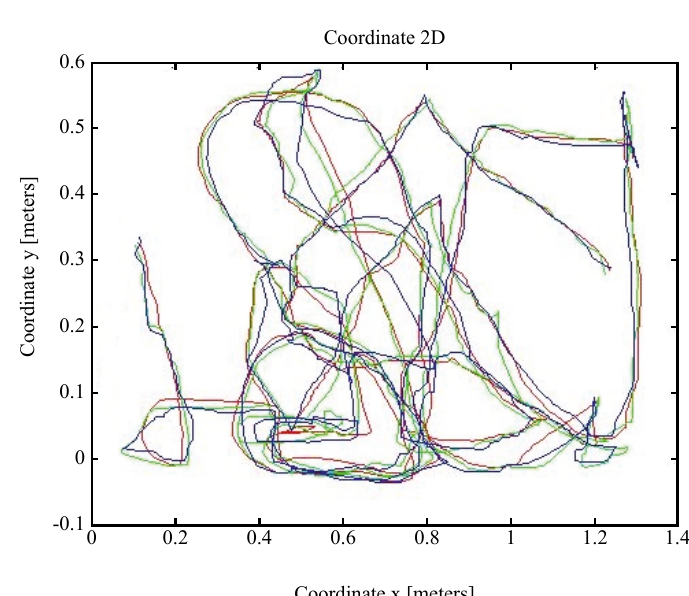
Figure 4. Image of the tracing of one rat in the enriched environment during the 10 minutes of the tracking. Red = evaluator n°1; green = evalu- ator n°2 and blue = evaluator